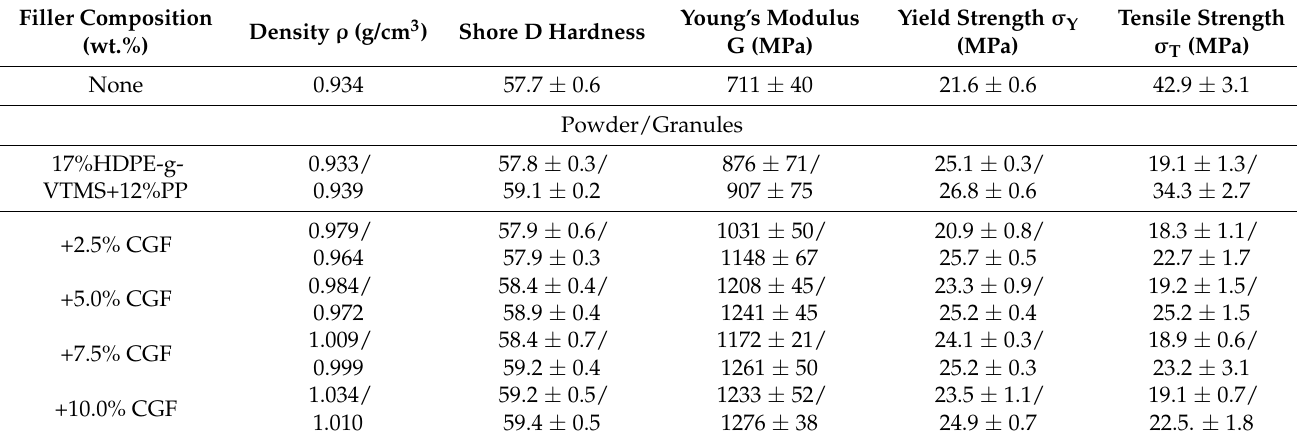
Table 4. The mechanical properties of neat UHMWPE and the ‘UHMWPE+17%HDPE-g-VTMS+12%PP’-based composites loaded with CGF (3 mm in